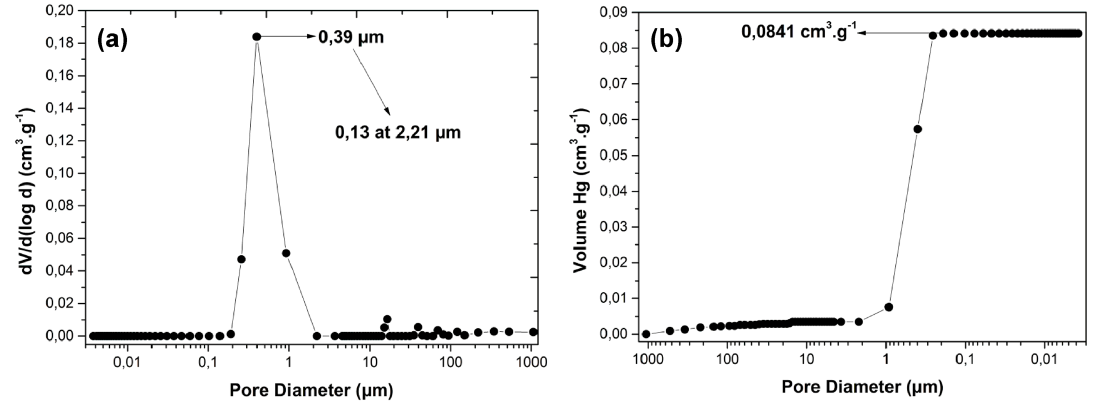
Figure 4. Pore size distribution by mercury intrusion porosimetry of tubular ceramic membrane of